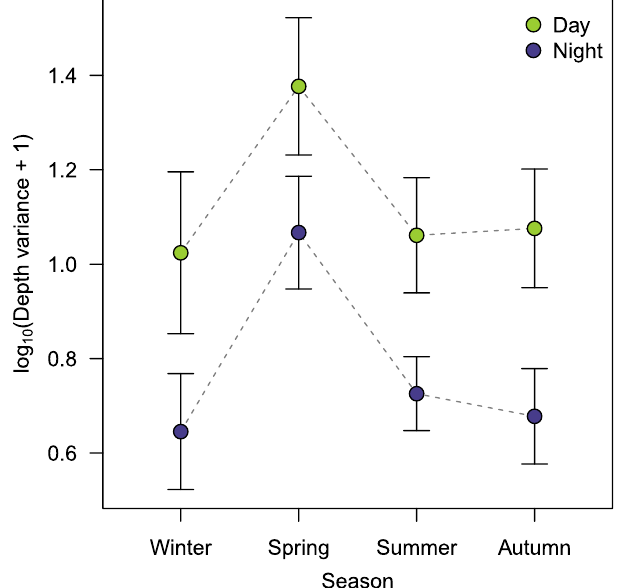
Figure 4. Effects of the day/night cycle and the season on the vertical movement activity of common dentex. Vertical movement activity is quantified as the variance of depth (after a logarithmic transformation). Filled circles and error bars represent the mean values predicted by the linear mixed effects model and the 95% confidence intervals, respectively.